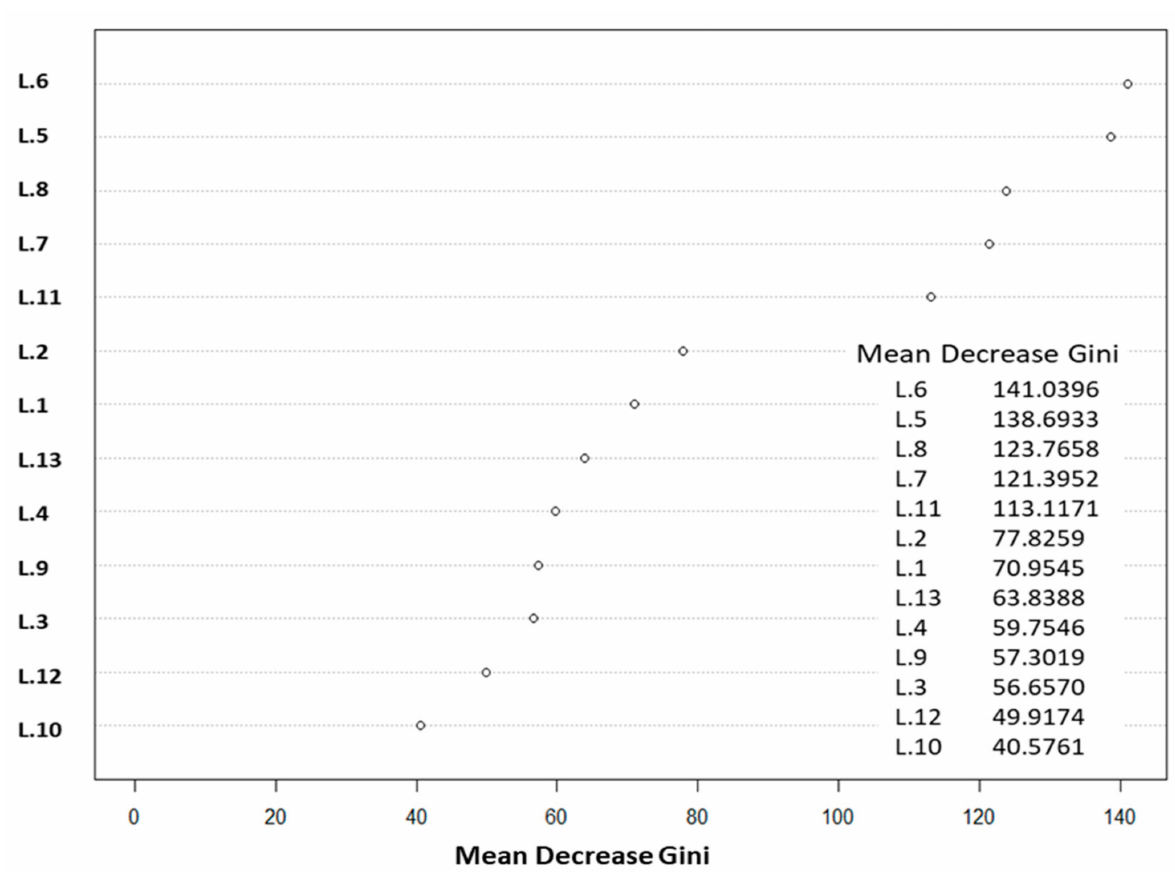
Figure 5. Random forest results: mean decrease Gini values for the 13 bands (L.1: band 1; L.2: band 2; L.3: band 3; L.4: band 4; L.5: GNDVI; L.6: NDVI; L.7: CVI; L.8: GVI; L.9: ICS; L.10: NLI; L.11: EVI; L.12: IB; L.13: SAVI).